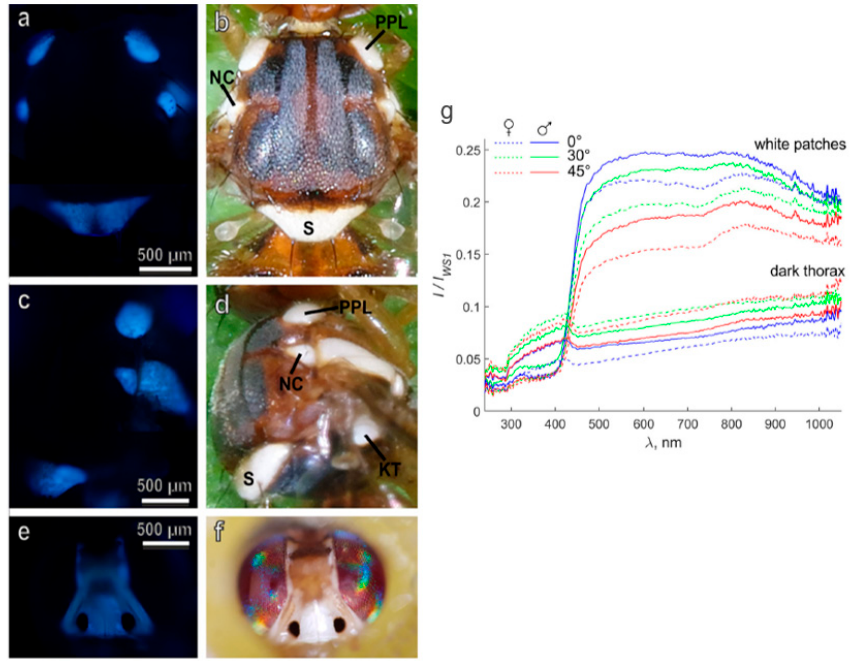
Figure 8. Images from the thorax (dorsal ( a , b ); lateral ( c , d )) and the head ( e , f ) of B. oleae , captured under fluorescence (excitation 365 nm, emission > 397 nm; ( a , c , e )) and bright field ( b , d , f ) light conditions. Notably, the bluish AF indicating the presence of resilin rises from the regions matching with the white patches; S, scutellum; PPL, post pronotal lobe; NC, notopleural callus; KT, katatergite. ( g ) Reflectance spectra recorded from dark areas and white patches of the surface of the thorax of B. oleae male and female individuals. Illumination was at 45°, and observed at variable degrees, identified by inset colors. Light scattering is due to the presence of biomaterial with several disordered surfaces and air-containing empty spaces in a phase of solid material, in this case represented by resilin. Modified from [97].